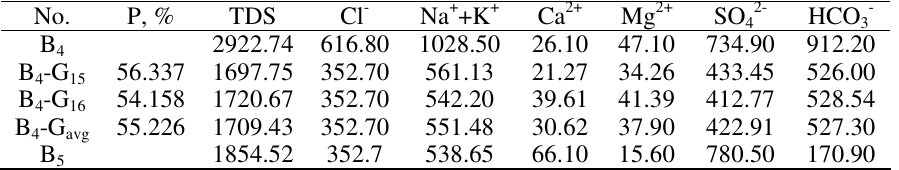
Table 4. Calculated mixing proportion and the corresponding concentrations of mixed waters (unit: